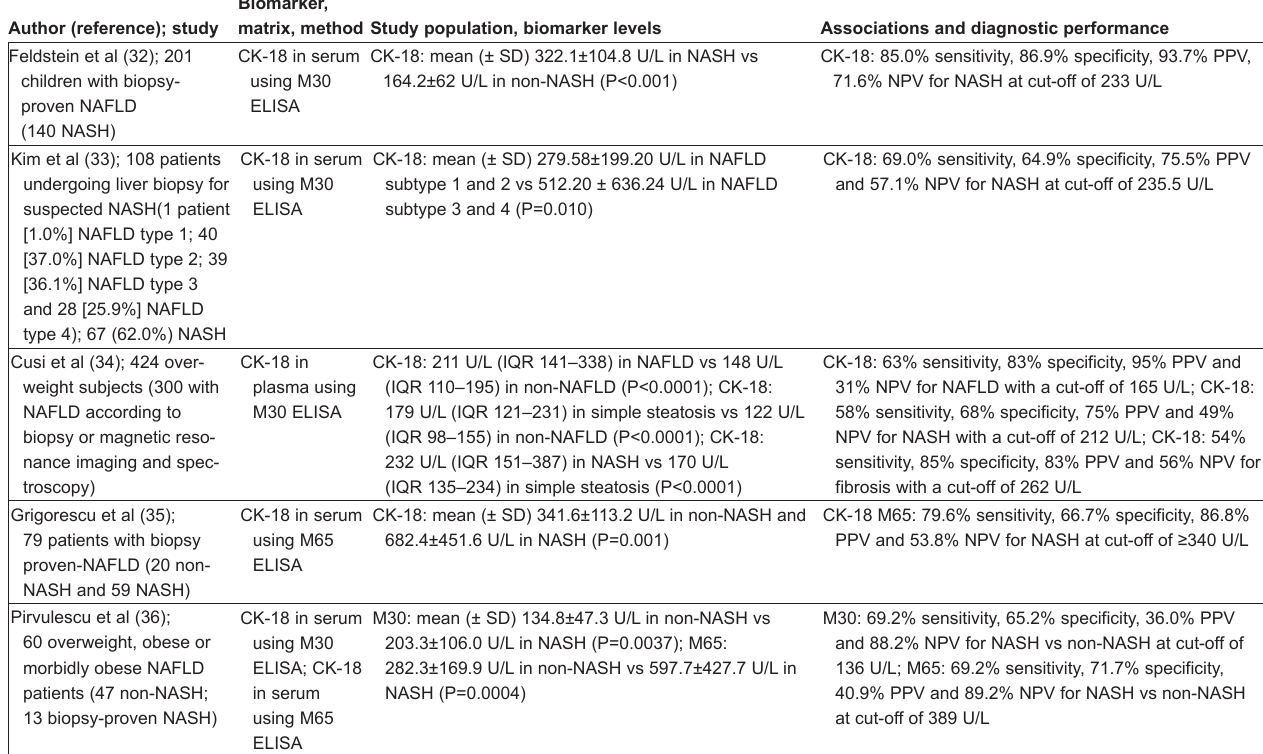
fibrosis with a cut-off of 262